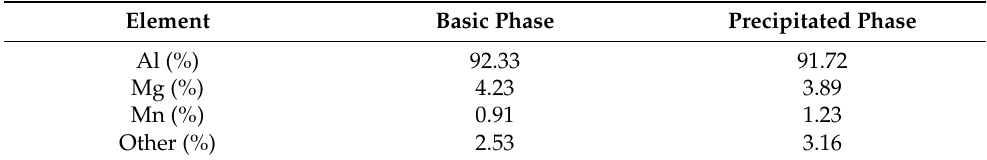
Table 3. Energy spectral scan results.